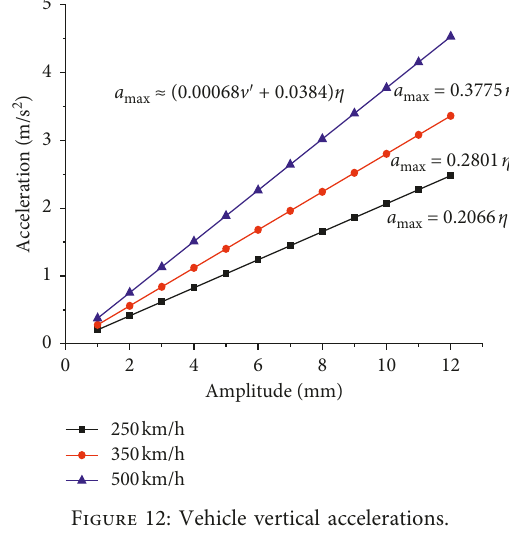
Figure 12: Vehicle vertical accelerations.